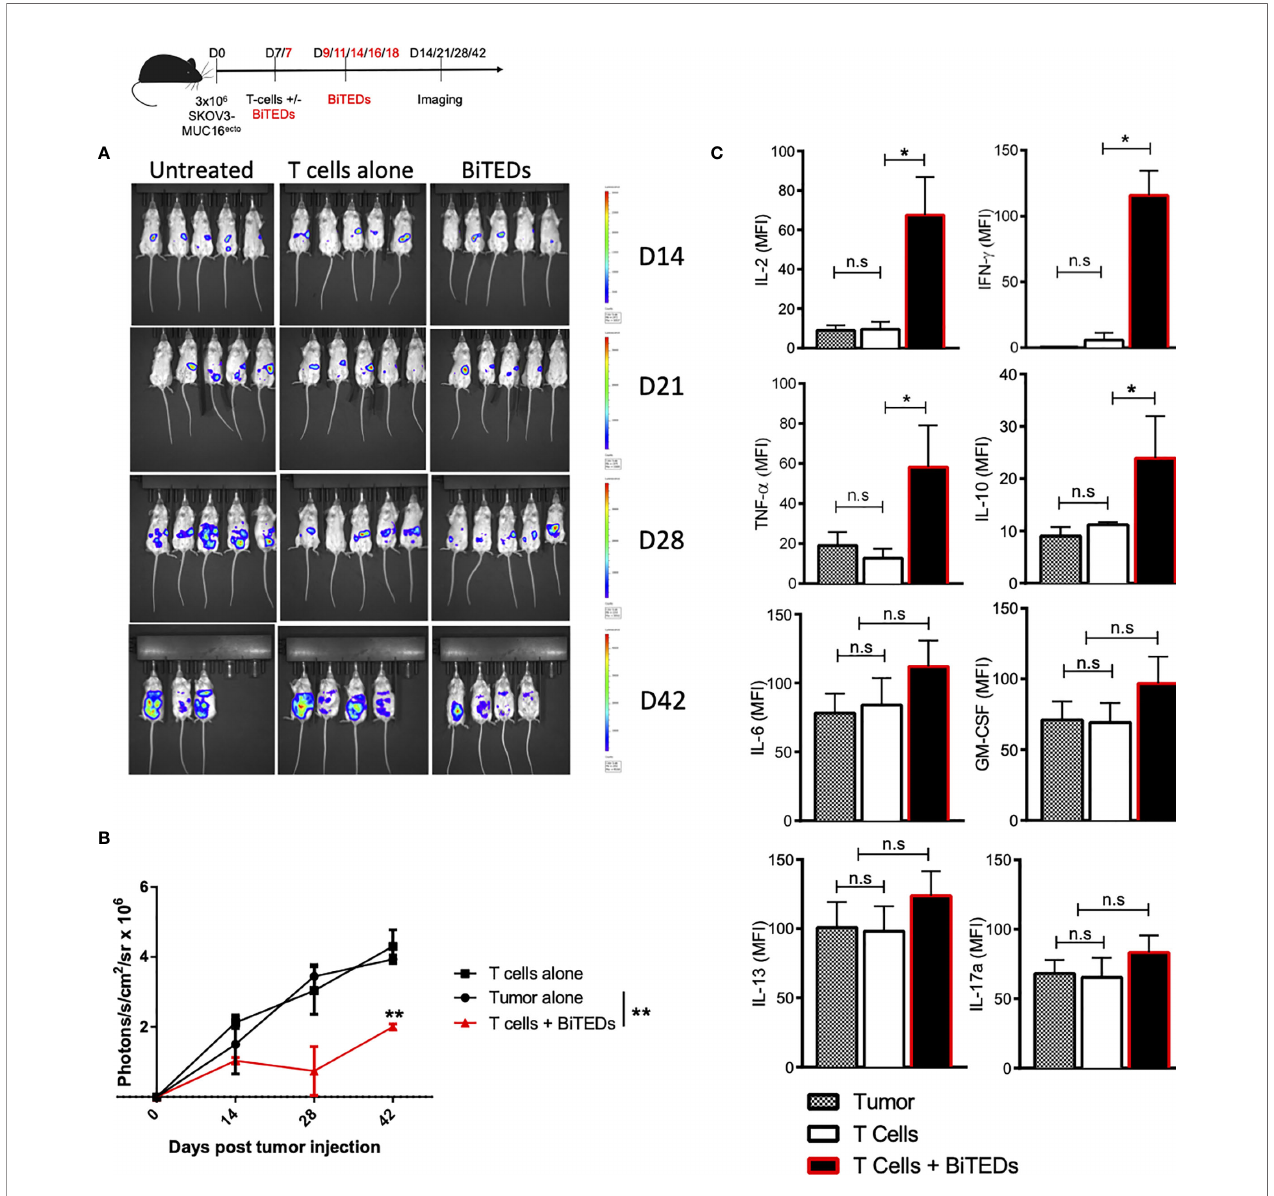
FIGURE 4 | MUC16 ecto speci fi c BiTEDs delay ovarian cancer progression in vivo. (A) Female NSG mice inoculated i.p. with SKOV3- MUC16 ecto -GFP-LUC tumor cells and subsequently treated with T-cells alone, or T-cells and MUC16 ecto - BiTEDs were imaged for tumor burden over time. Tumor was injected on D0 i.p. T-cells were injected on D7 i.v in all animals. Animals that received BiTEDs treated were dosed i.p on D7, D9, D11, D14, D16 and D18. (B) Quanti fi cation of bioluminescence from (A) . (C) Female NSG tumor bearing mice were treated with T-cells alone or T-cells and MUC16 ecto - BiTEDs. Serum cytokines were evaluated 7-days after treatment. Data shown are pooled results from 2 independent experiments with at least 3 independent donors. Data are plotted as mean ± SEM. *p < 0.01, **p < 0.05. ns, not signi fi